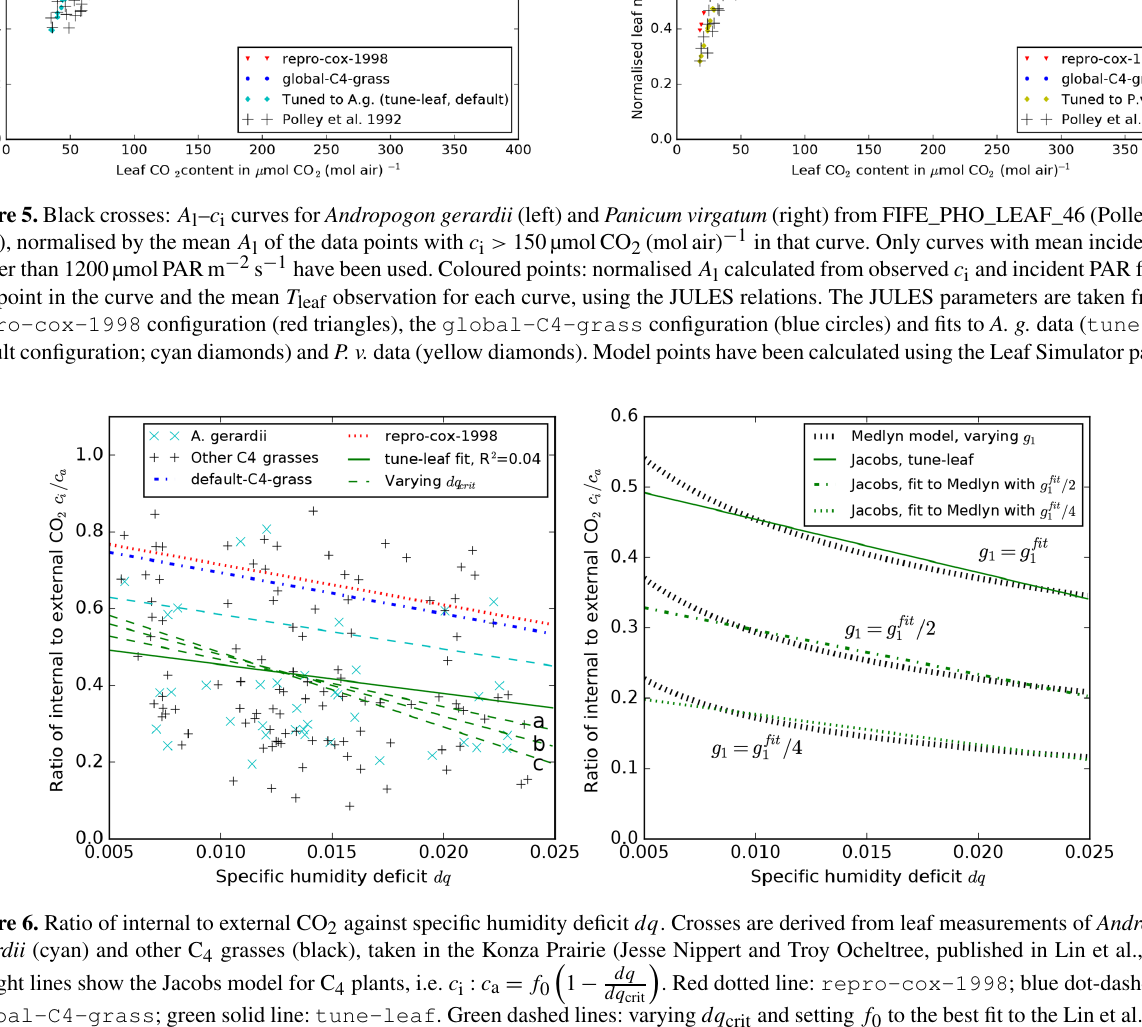
(cid:16) (cid:17) 1 − dq . Red dotted line: repro-cox-1998 ; blue dot-dashed line: dq crit / 2, g fit / 4, where g fit , g fit is the value of the Medlyn model parameter g 1 1 1 1 1 (because they have both been fit to the same dataset). The green dot-dashed and green 1 / 2 and g 1 = g fit / 4, 1 1